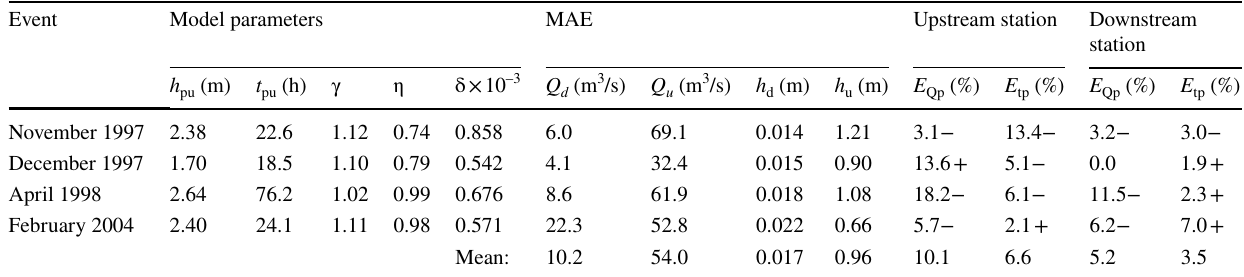
Table 5 Optimal values of the model parameters and the perfor- mance measures for the events observed in P. Nuovo-M. Molino river reach ( h pu : upstream peak stage, t pu : upstream stage peak time, γ, η,